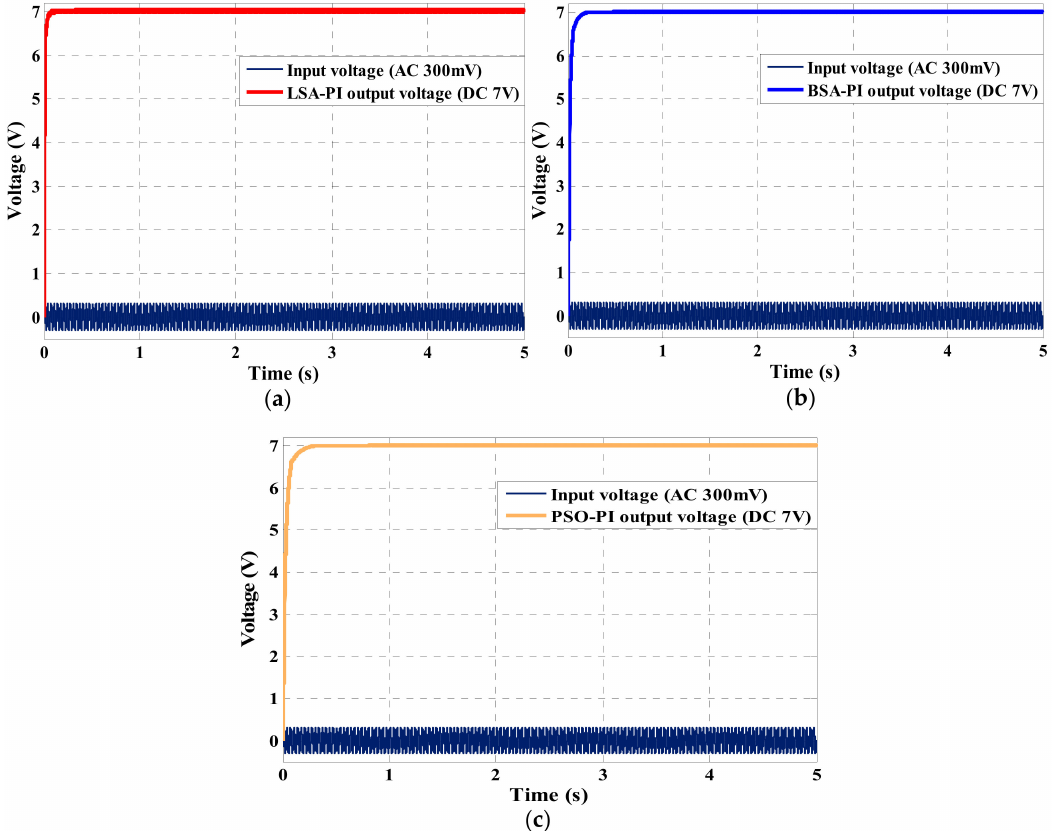
Figure 18. Simulation outputs of a PEHS using a LSA-PI ( a ), BSA-PI; ( b ) PSO-PI; ( c ) controller with input 300 mV.